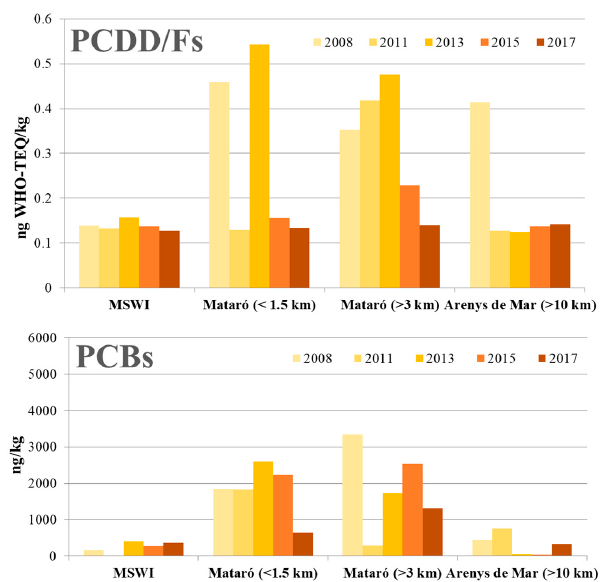
Figure 2. Temporal trend of the levels of PCDD/Fs and PCBs in samples of soils collected in the neighbourhoods of the MSWI of Mataró in 2008, 2011, 2013, 2015 and 2017.